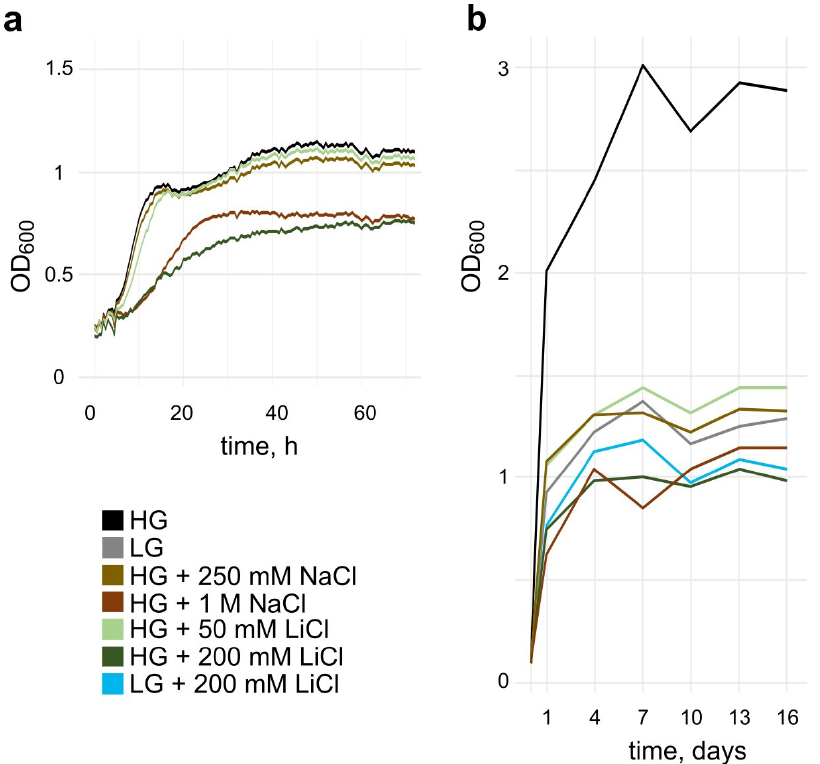
Figure 1. Growth curves of S. cerevisiae strain BY4741 in SDM, supplemented with 2% glucose (unless indicated otherwise). Growth conditions were applied at timepoint 0. HG = High Glucose, 2% (w/v); LG = Low Glucose, 0.5% (w/v). Experiments were run in triplicates and plotted as an average. ( a ): Optical density measured from cultures grown in a honeycomb plate with a Bioscreen C instrument for 71 h. ( b ): Optical density measurement with a spectrophotometer of samples taken from cultures grown in 50 mL Falcon tubes over 16 days.